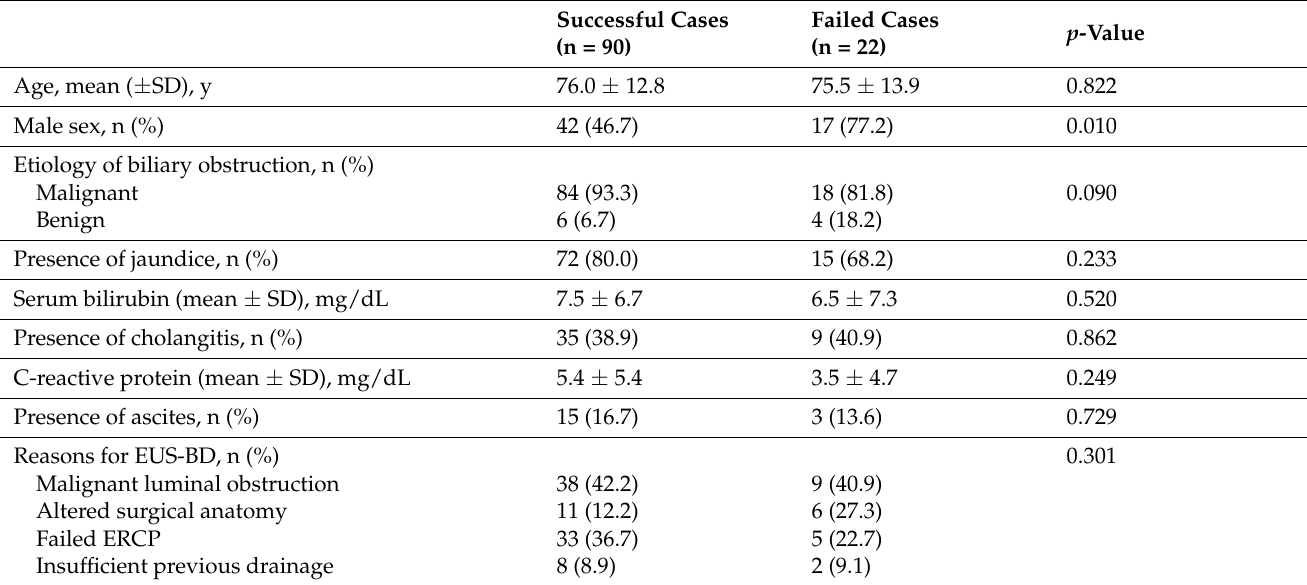
Table 1. Patient characteristics in successful and failed cases.